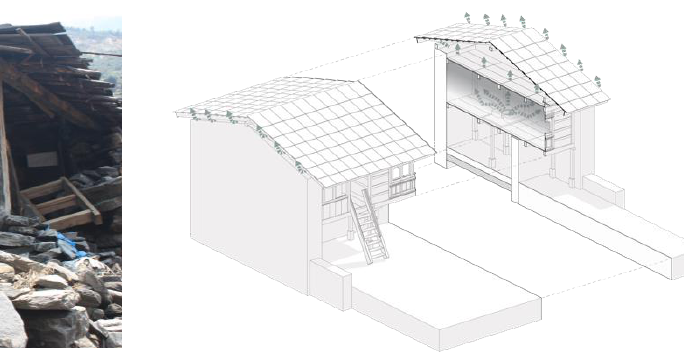
Figure 17. Collapsed house 2016 (Authors).